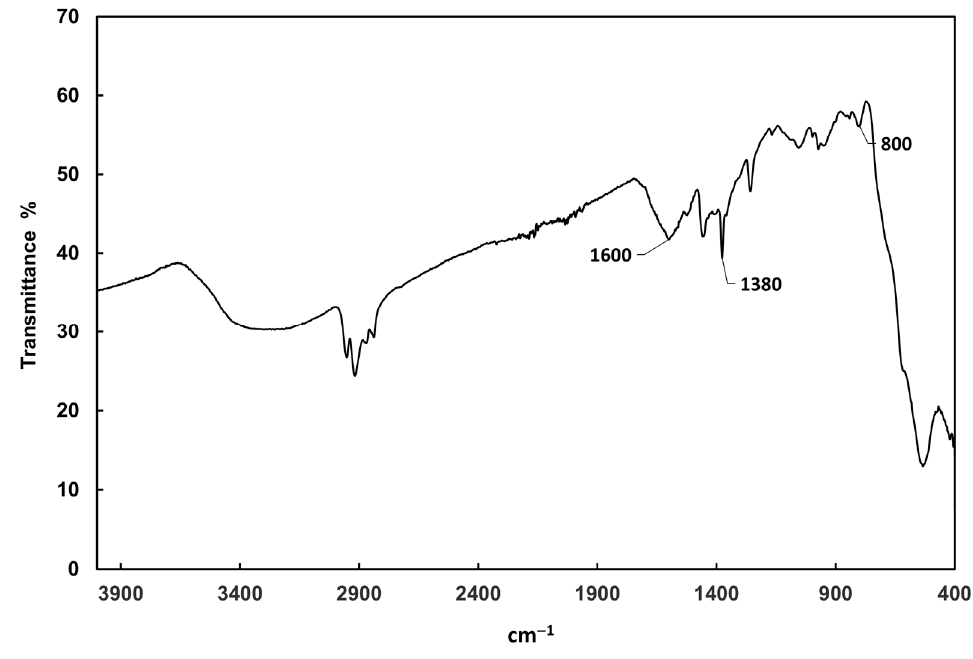
Figure 3. FTIR spectrum for Fe 3 O 4 @Ag after nitrate adsorption. Signals at 800, 1380 and 1600 cm − 1 correspond to NO 3